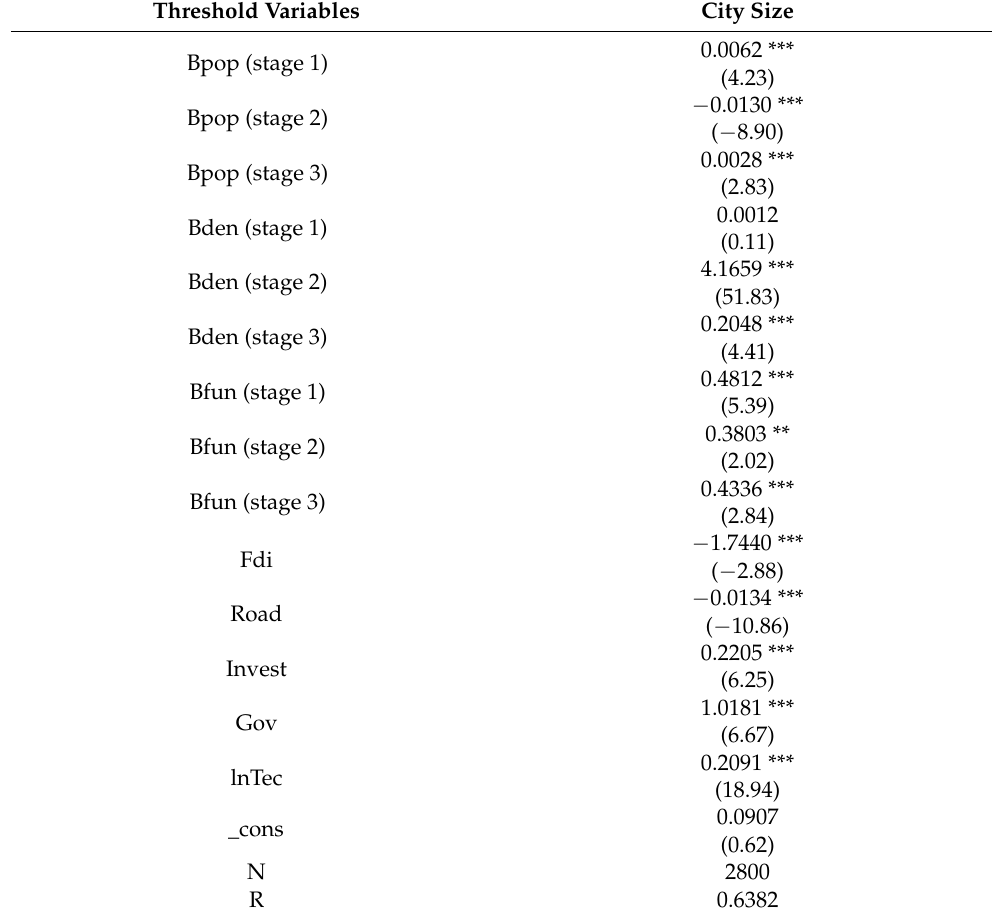
Table 7. Estimation results of double-threshold